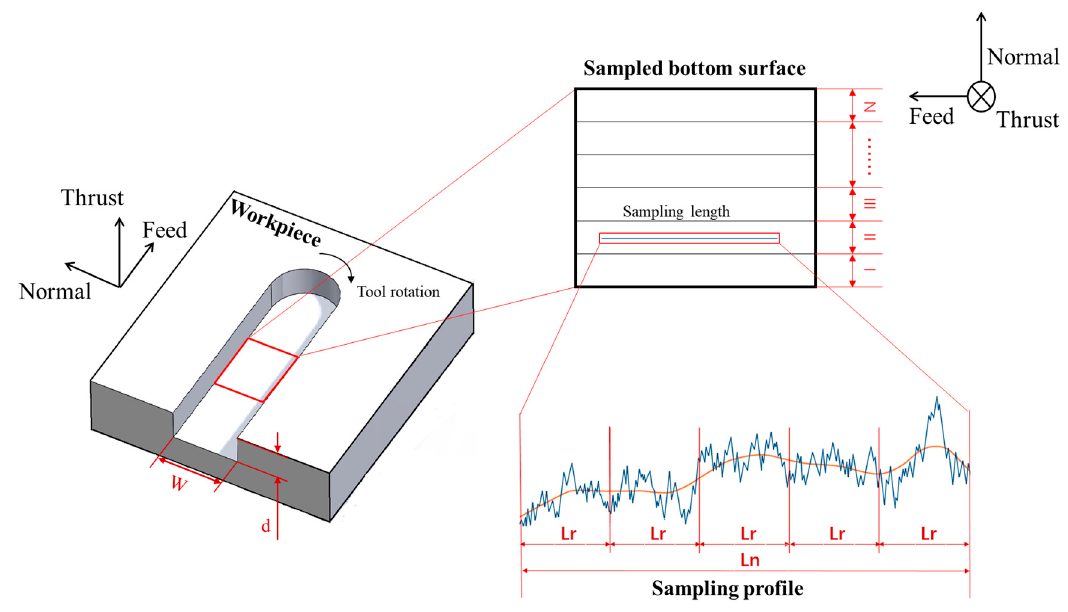
Figure 5. Model for calculating relative standard deviation of roughness (RSDS) .